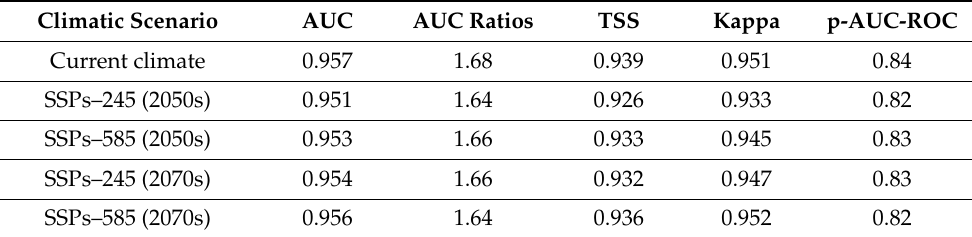
Table 2. Different accuracy measures and their averaged values over 10 replicate runs for considered predictive maximum entropy models of P. gerardiana in the study area. Climatic Scenario AUC AUC Ratios TSS Kappa p-AUC-ROC Current climate 0.957